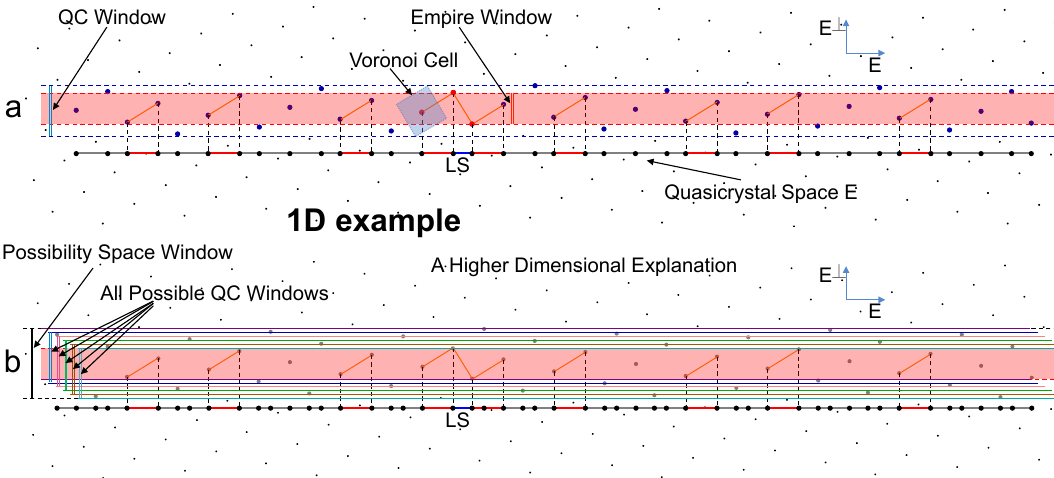
Figure 1. Cut-and-project windows in a rotated Z 2 lattice used for generating a 1D quasicrystal and its associated structures. ( a ) The Z 2 lattice is rotated so that the quasicrystal space ( E ) coincides with the horizontal line and the perpendicular space ( E ⊥ ) lies along the vertical line. The blue vertical line is the QC window, which covers all points and square edges (unit cells of Z 2 lattice) that lie between the two dashed blue horizontal lines. All these points get projected to the horizontal space as the vertices of the 1D quasicrystal and all these edges get projected as the tiles of the quasicrystal. The red vertical line defines the empire window for the LS vertex type, which covers all the edges between the two dashed red horizontal lines. These edges, after being projected to the horizontal space, become the empire of the LS vertex type. ( b ) The colored vertical lines give examples of possible QC windows that cover the empire window. The union of all these QC windows gives the possibility space window, which covers all the tiles that can possibly coexist with the LS vertex